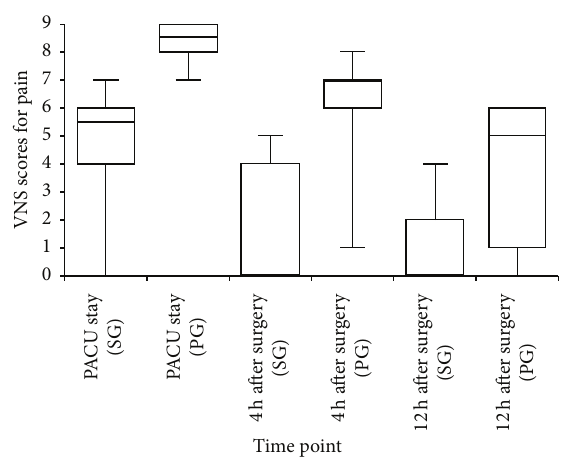
Figure 2: Pain scores during PACU stay and at 4 and 12 h after surgery. PACU: postanesthesia care unit; PG: placebo group; SG: S(+)-ketamine